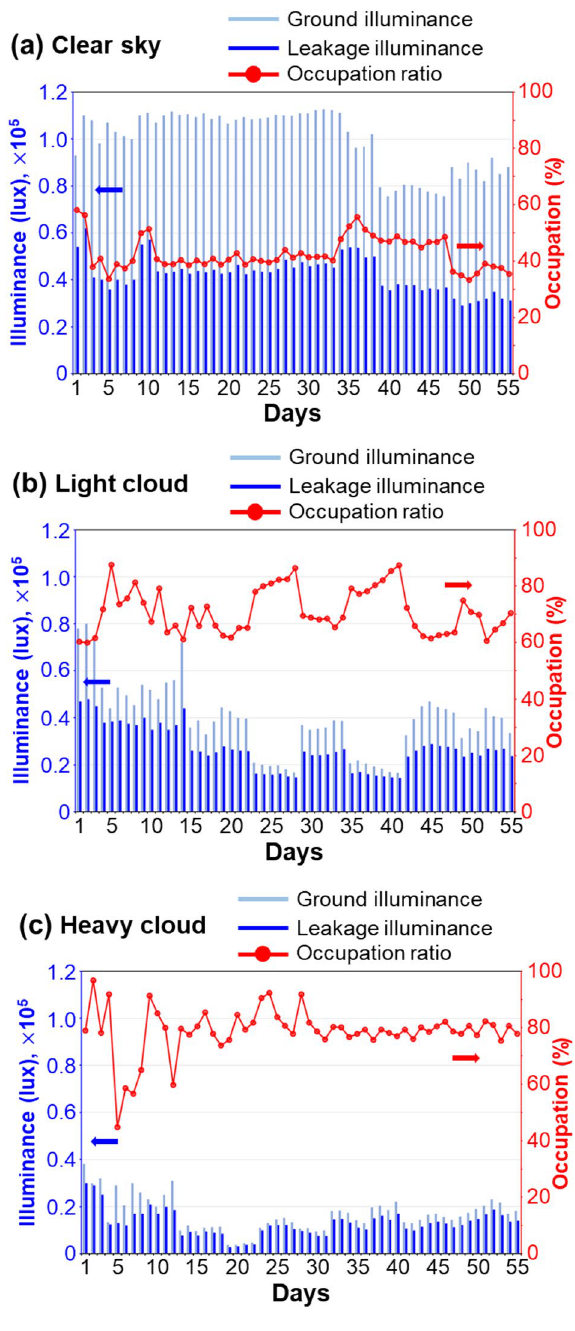
Figure 5. Field measurement results under different weather conditions. ( a ) Clear sky, ( b ) light cloud, and ( c ) heavy cloud. Even on cloudy days, the area where the light dissipates can still have nearly 80% of the light due